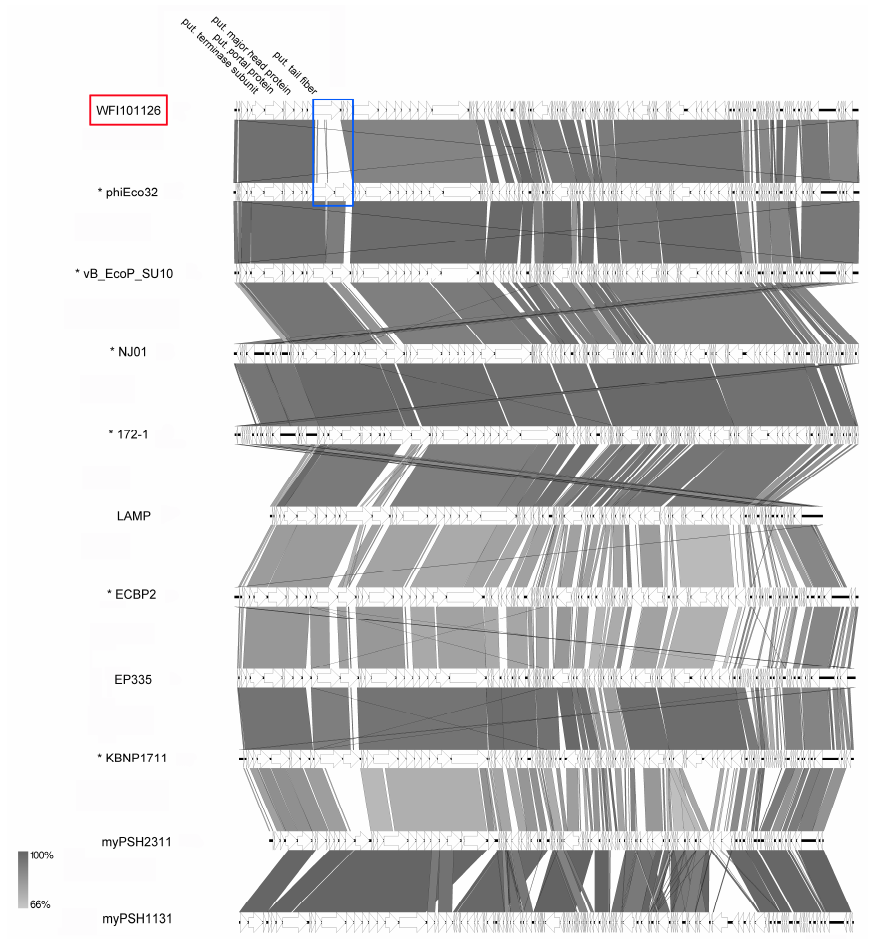
Figure 11. Synteny plot of phage WFI101126 compared to other kuraviruses at the nucleotide level (pairwise comparison with the genome next to it on the figure). The figure was generated with EasyFig [48]. Asterisks indicate o ffi cial classification as the genus Kuravirus is already recognized by ICTV. Isolates of this study are marked in